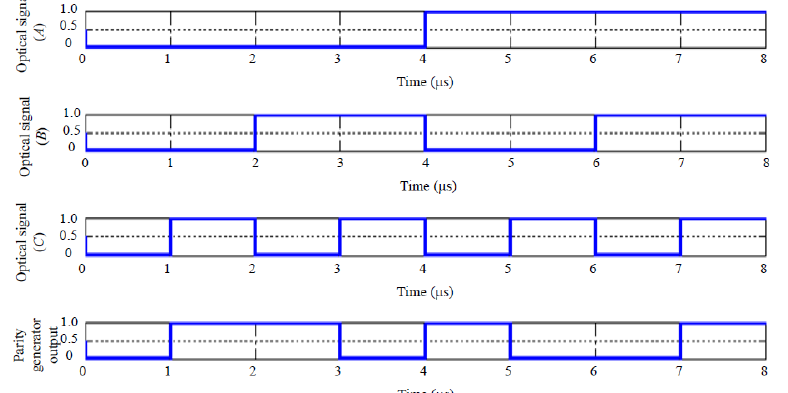
Fig. 5 Timing diagram of even parity generator through MATLAB.